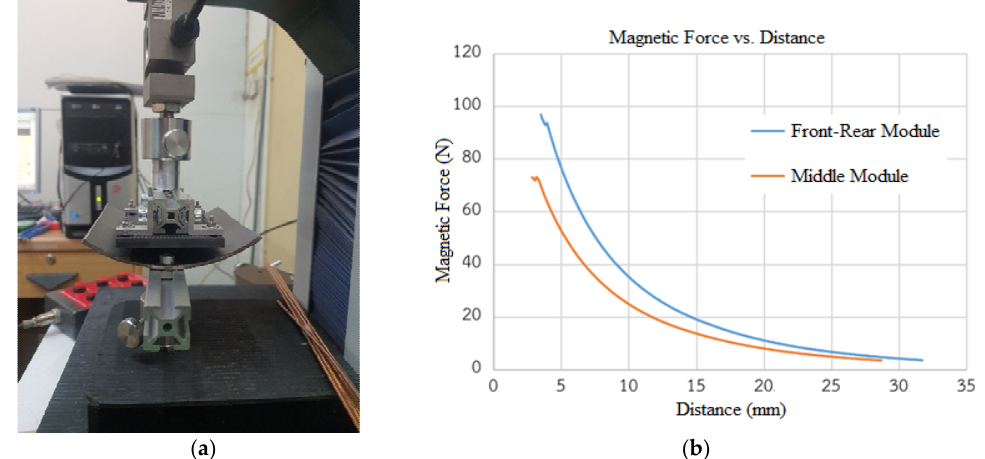
Figure 8. ( a ) The experimental setup and ( b ) the results demonstrating the influence of distance on the magnetic force. Table 2. The power, speed, and torque requirements of the motor.